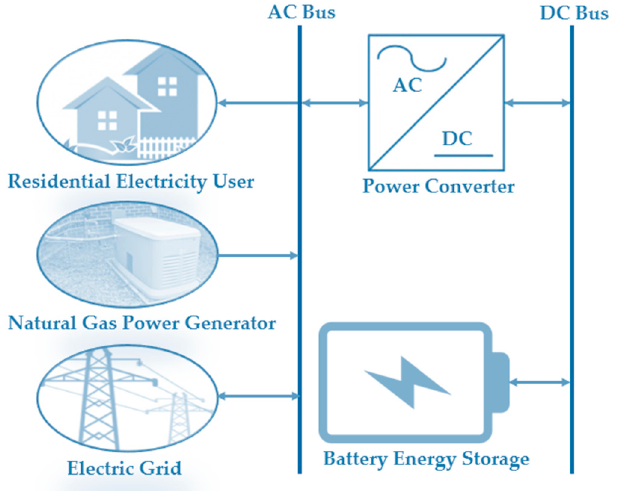
Figure 6. Schematic view of EG + NGPG + BES based power supply system configuration [Note: EG—Electric grid; BES—Battery energy storage; NGPG—Natural gas power generator; DC—Direct current; AC—Alternating current].